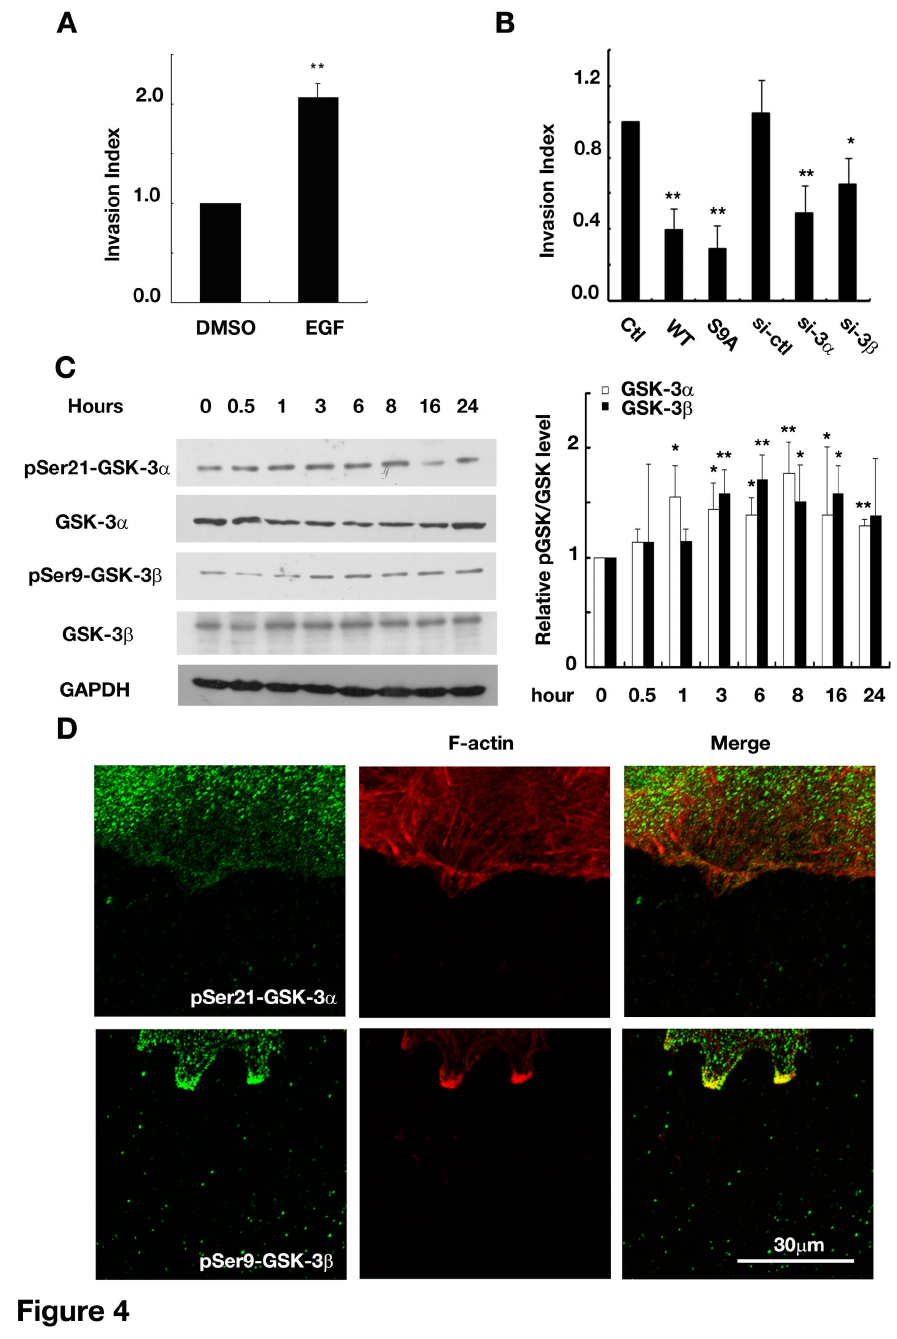
Figure 4. Roles of GSK-3 in EGF-promoted glioma cell invasion. (A) EGF promoted U87 cell invasion in the transwell assay. ** P <0.01 versus DMSO .(B) GSK-3 knock-down and uniform up-regulation of GSK-3β activities inhibited U87 cell invasion. * P <0.05, ** P <0.01 versus pcDNA3 ( ctl ) or non-sense control ( si-ctl ). (C) Up-regulation of p-Ser-GSK-3 levels during EGF-induced wound recovery of U251 cells. Left : representative western blots of U251 cell lysates collected at indicated time points after scratching. Right : statistics of pSer-GSK-3 levels normalized to GSK-3 levels and then compared with the value at 0hr. * P <0.05, ** P <0.01 versus the value of pGSK-3/GSK-3 at 0hr. (D) Location of increased pGSK-3 staining in EGF-induced wound recovery of U251 cells 3 hrs after scratching. Green : anti-pSer21-GSK-3αor anti-pSer9-GSK-3β; Red : rhodamine phalloidin. Original magnification, 400× . si-3α, siRNA against GSK-3α; si-3β, siRNA against GSK-3β; WT, wild-type form of GSK-3β; S9A, constitutively active form of GSK-3β. Data were mean ± SD of three independent experiments. EGF, 40ng/ml. doi: 10.1371/journal.pone.0081814.g004 PLOS ONE |